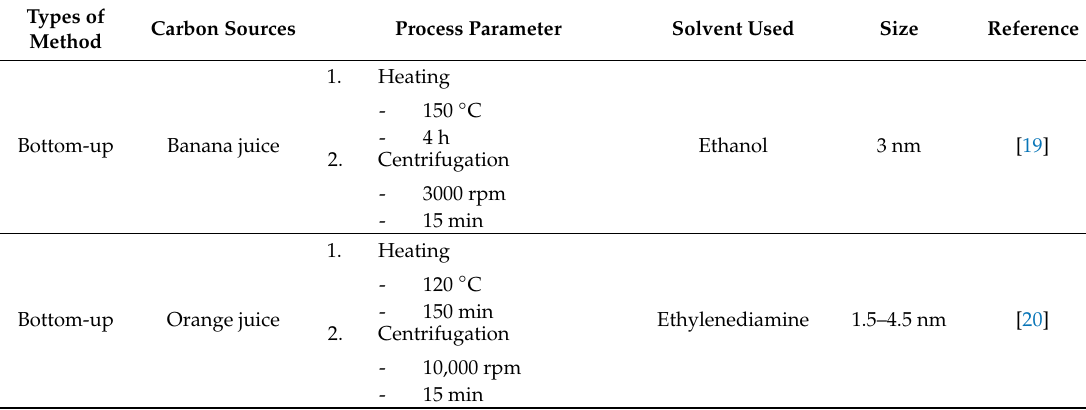
Table 1. Comparison of carbon quantum dots (CQD) synthesis methods using hydrothermal